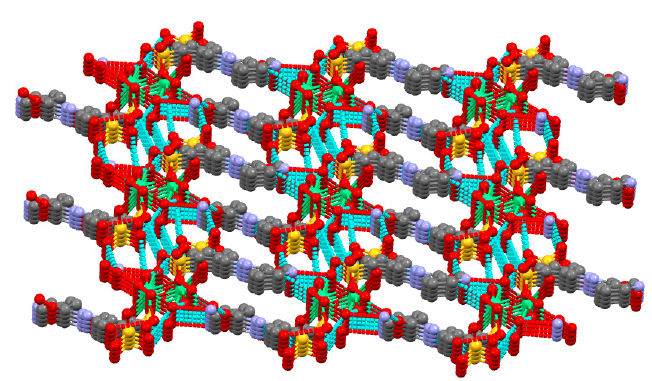
Figure 3. 1D chained structure of 1 .